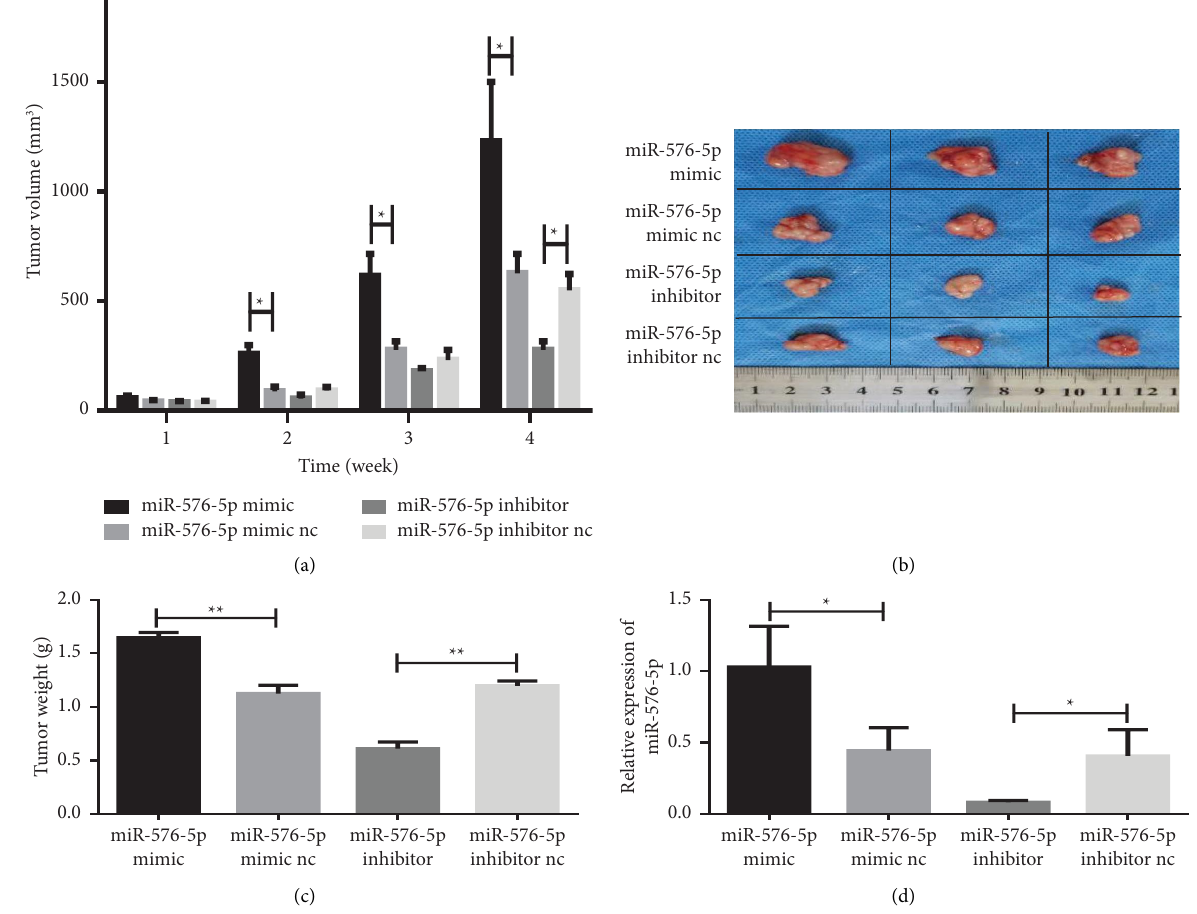
Figure 7: miR-576-5p promotes tumour growth in vivo. (a) Tumour volume was measured weekly after injection of transfected TPC-1 cells. (b) After the mice were killed, the tumour tissue was imaged. (c) Te tumour weight was measured after the mice were killed. (d) Expression of miR-576-5p in tumour tissues was detected by RT ‒ qPCR. ∗ P < 0 . 05 ; ∗∗ P < 0 .